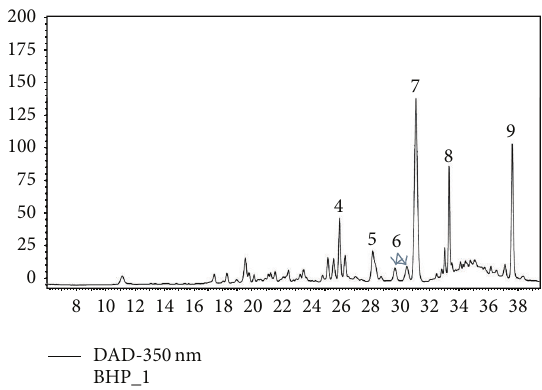
Figure 3: HPLC profile of polyphenols detected separated on Protect-1 C18 column and detected at 350 nm. 4: luteolin-rutinoside, 5: quercetin-glucoside, 6: quercetin-glycosides (the sum of these compounds is used in Table 3), 7: luteolin-glucoside, 8: myricetin, and 9: